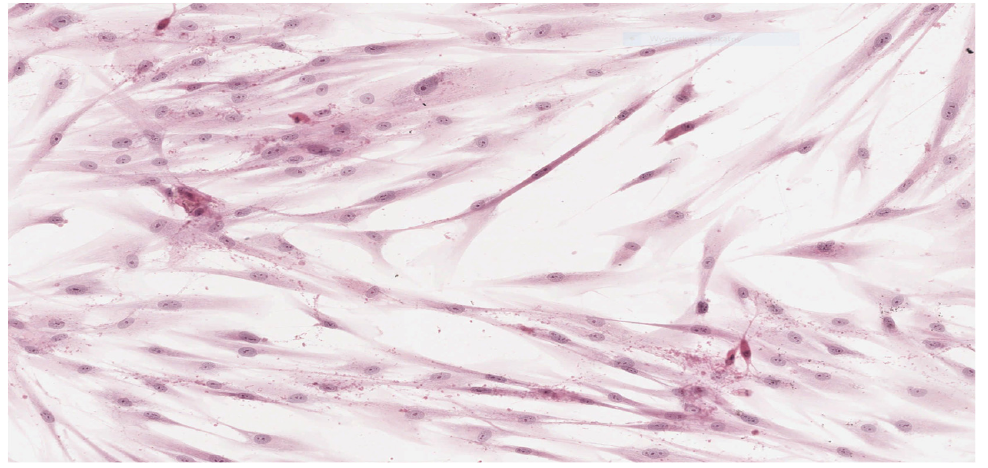
Figure 3. Image of cells cultured on medium with BLEND-A-DENT Plus; 100× magnification.